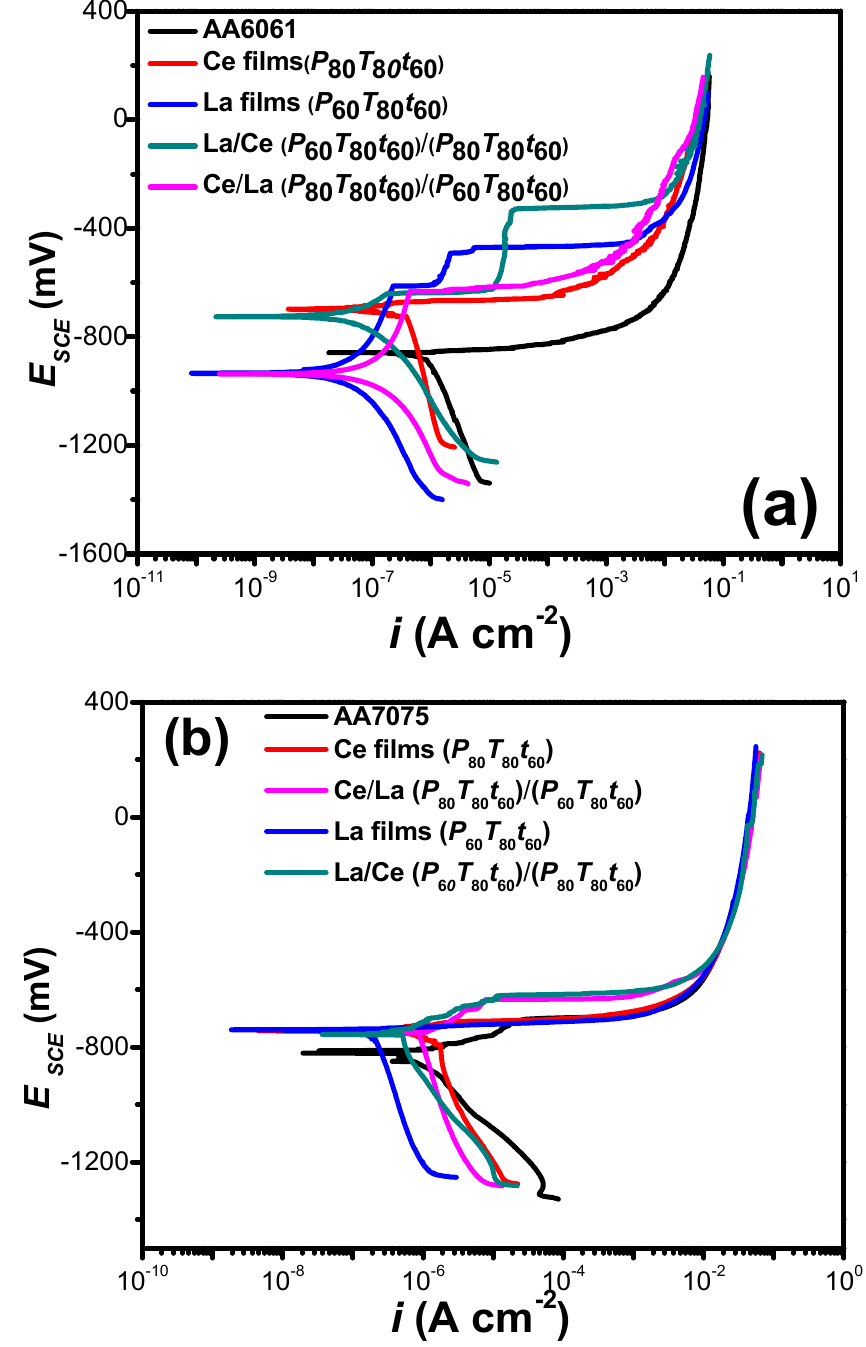
Figure 9. Polarization curves of RE coatings synthesized at 60 or 80 W ( T = 80 °C and t = 60 min) and bilayered coatings on: ( a ) AA7075 and ( b ) AA6061 aluminum alloys.